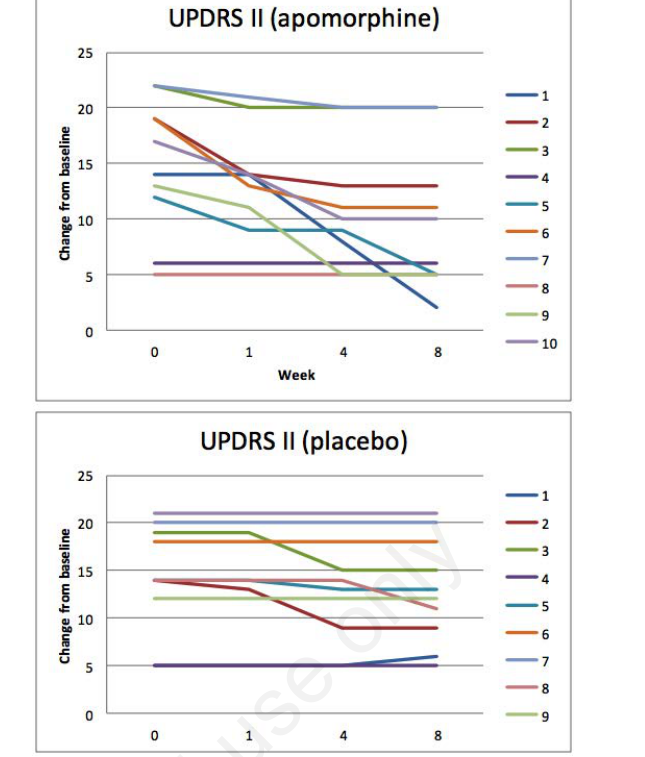
Figure 2. Total scores change from baseline over time (weeks) in UPDRS part II. Apomorphine and placebo groups.